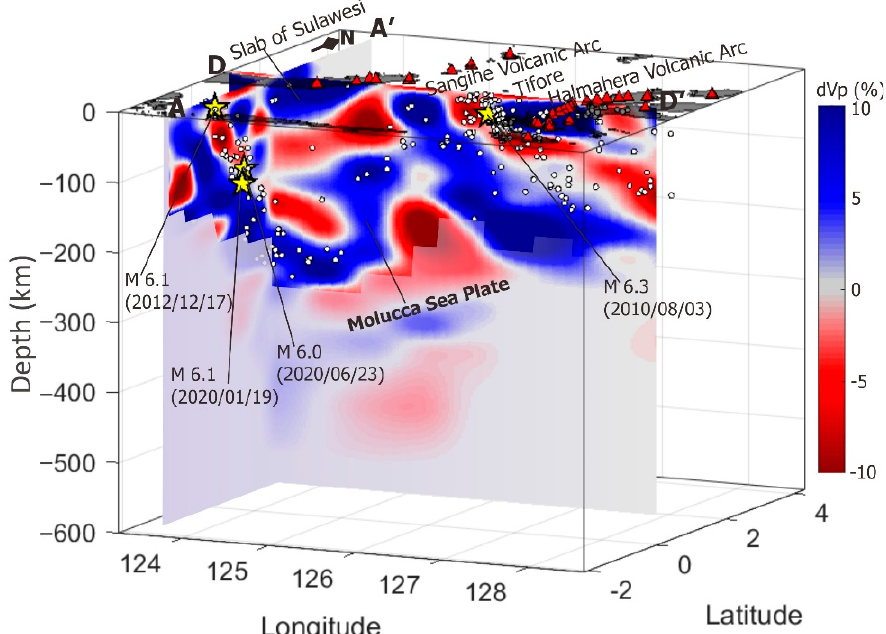
Figure 10. The 3D visualization of the Molucca Sea Plate, combining vertical cross-section profile A-A ′ (south–north) and profile D-D’ (west–east) from the P-wave tomography inversion results. The earthquake events follow the high Vp anomaly pattern. The red color indicates low-velocity areas and low Vp/Vs ratio, and the blue color indicates high velocity and high Vp/Vs ratio. The white dots signify earthquakes; the yellow stars signify earthquakes with significant magnitudes. The red triangle is a volcanic arc located in Sangihe and Halmahera.